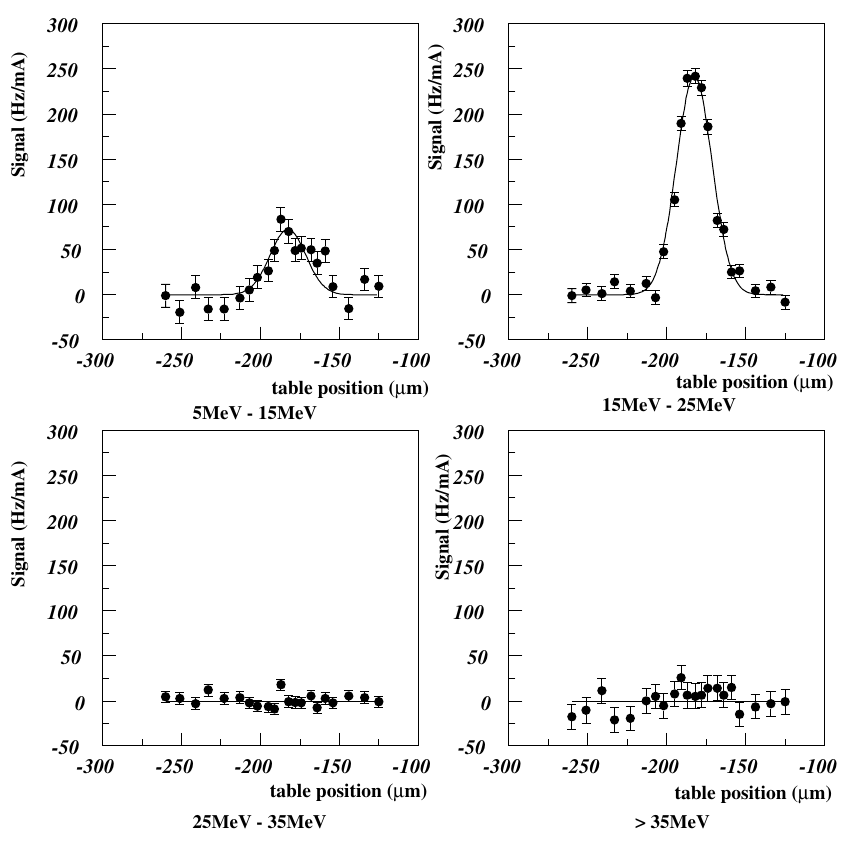
FIG. 8. Normalized signal count versus the laser wire position. The plots are for four different energy intervals (labeled by the subtitle at the bottom) of the same electron beam current (1.0–1.4 mA). Data from ( 2000 = 12 = 05